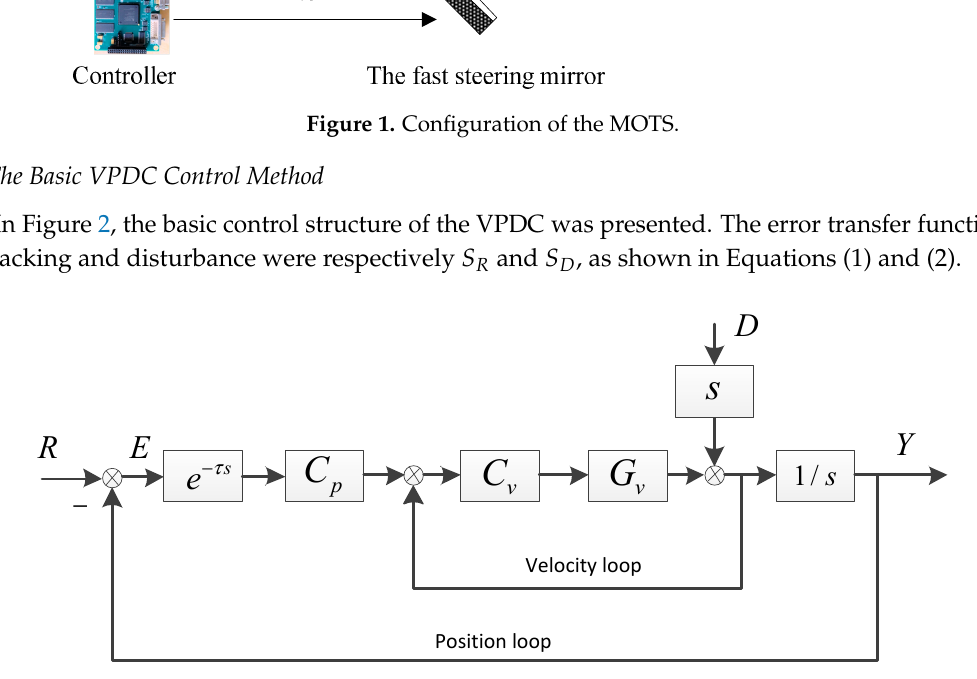
Figure 2. The VPDC structure. G v refers to the velocity open-loop transfer function. C v and C p respectively refer to the velocity controller and position controller. e − τ s refers to the delay element of the CCD. E refers to the boresight error without delay. R and D respectively refer to the target signal and the external disturbance signal. Y refers to the corresponding movement of the boresight .